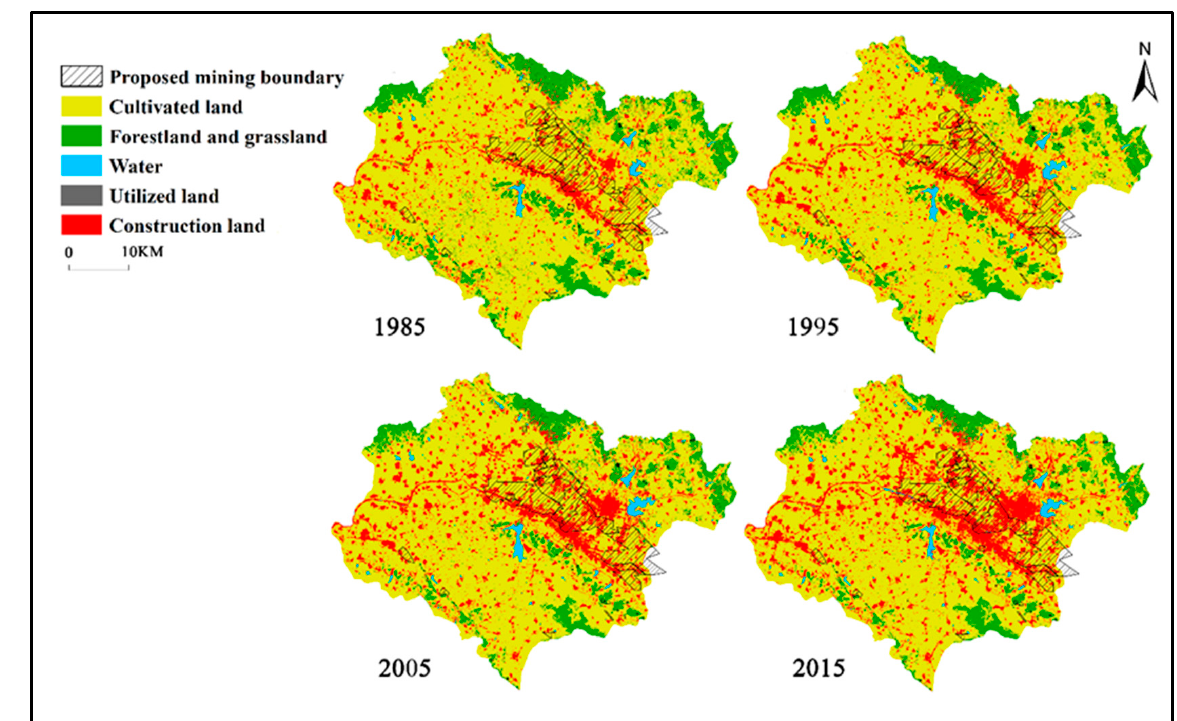
Figure 5. Land–Use Classi fi cation Map.